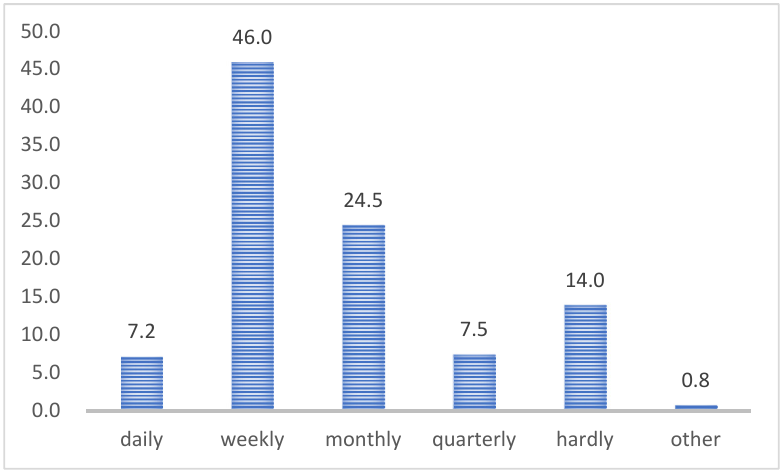
Figure 3. Visits’ frequency of sample distribution. Table 14. Hosmer and Lemeshow test results. Table 15. Results of logistic regression analysis for frequency of visits to the library.